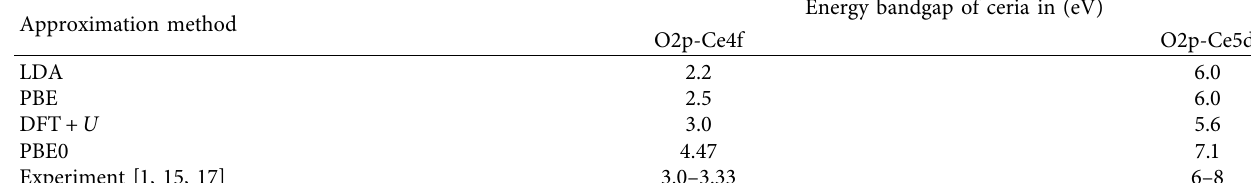
Table 1: Calculated and experimental bandgap of ceria in